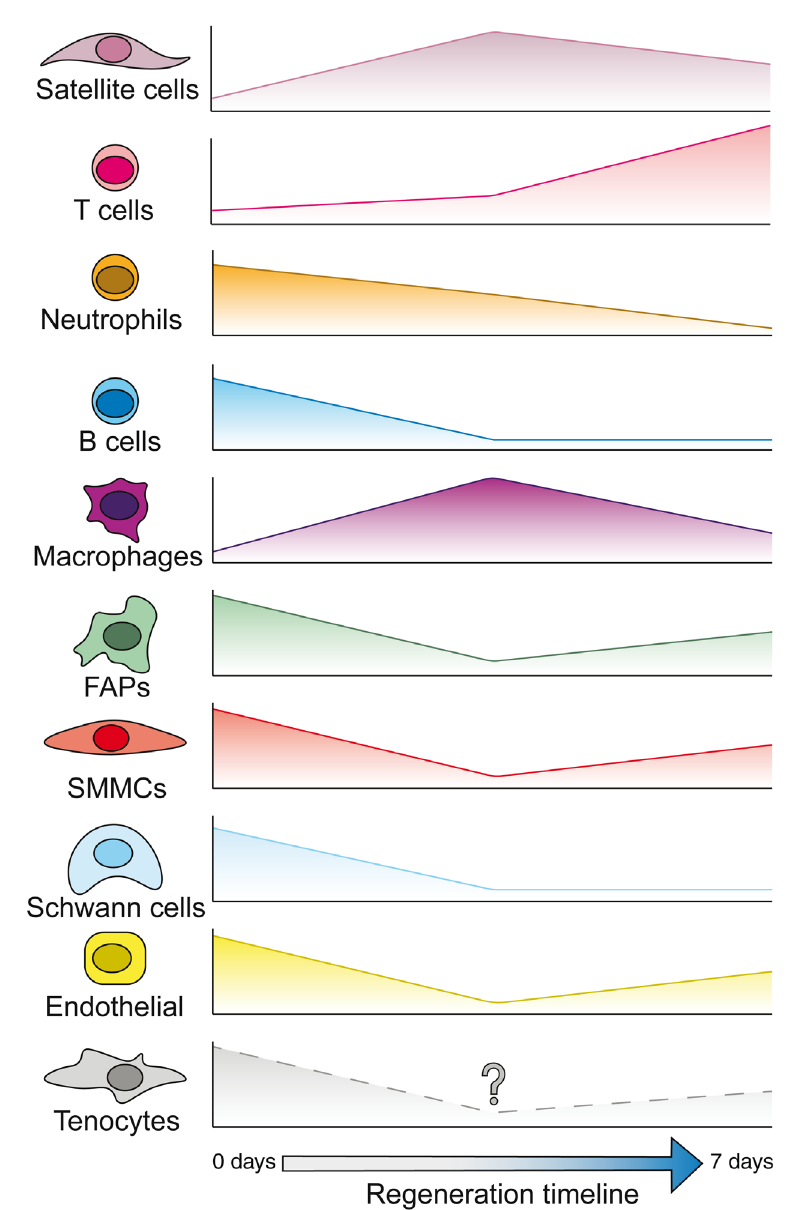
Figure 2. Dynamics of muscle-resident cells during regeneration. Single-cell RNA sequencing has been used to describe the dynamics of multiple muscle-resident cells through regeneration following injury 28,29 . Plotted are the relative proportion of each cell type compared to the bulk cell population at each stage. Some cells, such as satellite cells and T cells, make up a higher proportion of the population following injury. Others, like B cells and fibro-adipogenic progenitors (FAPs), seem to be comparatively reduced in numbers. It is unknown how tenocytes react during muscle regeneration. However, they may follow the same trend as FAPs owing to them not being discriminated from FAPs in the fibroblast